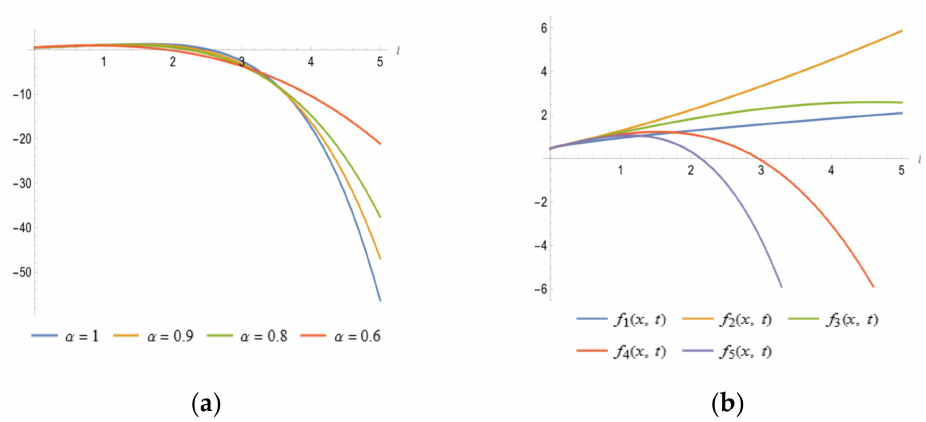
Figure 6. ( a ) The 2D graphic of f 5 ( x , t ) at r = − 1 and x = 0.8 for different α = 1, 0.9, 0.8, 0.6 in Example 1. ( b ) The 2D graphic of f n ( x , t ) , n = 1,2,3,4,5, at r = − 1, α = 1, and x = 0.8 in Example 1.